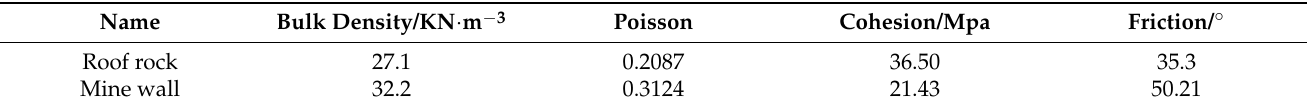
Table 1. Mechanical parameters of mine wall and overlying surrounding